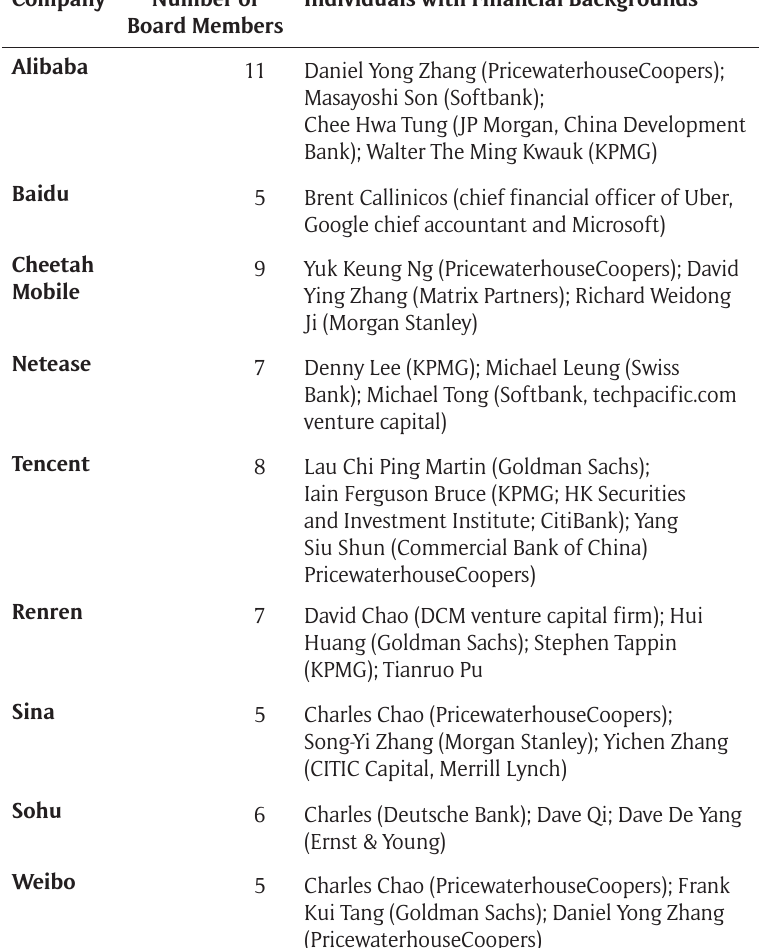
Table 5: Individuals with Financial Networks in Company’s Board of